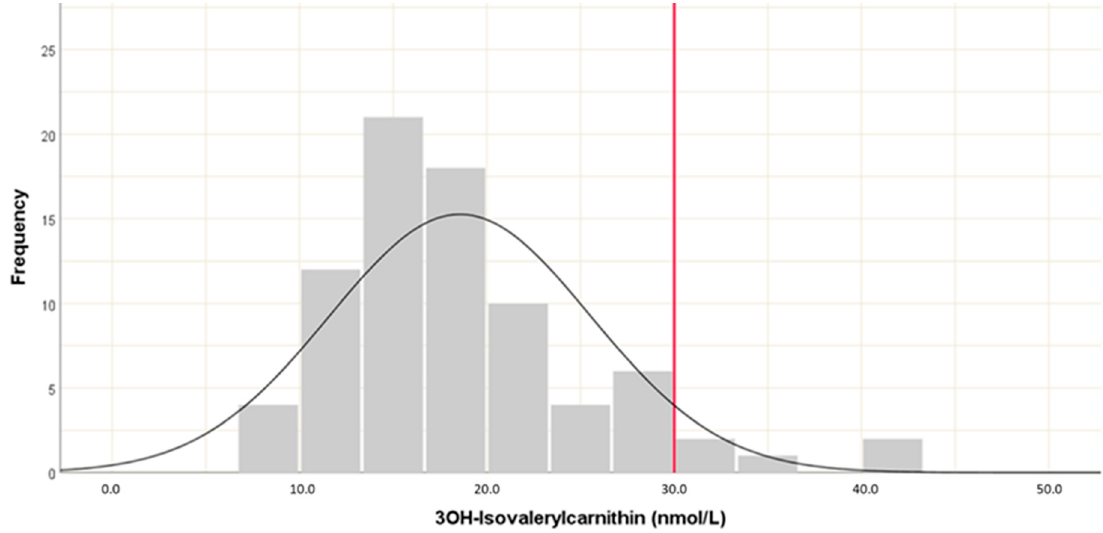
Figure 1. Predicted reference value for serum 3HIVAc levels from control samples.